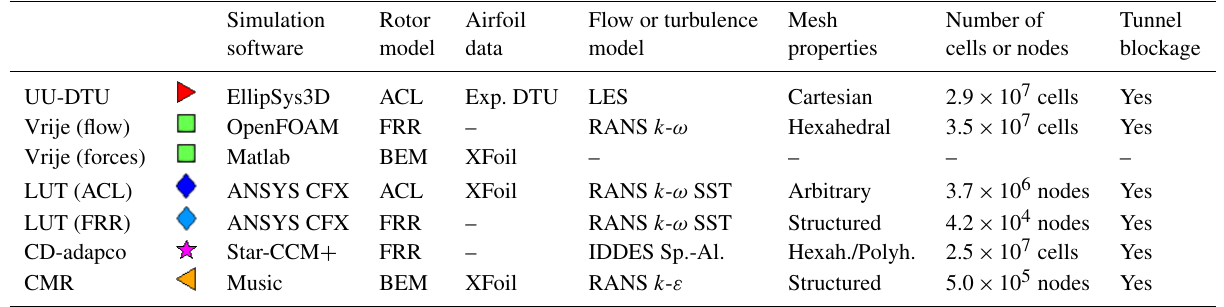
Figure 4. Measured and rotor-averaged values of normalized mean velocity U/U ref (a) and turbulence intensity TI [%] (b) at the position of T1 ( x/D = 0) and the positions of T2 ( x/D = 0, 2.77, 5.18, 9.00) in the empty tunnel for test case C (shear flow grid). Table 1. Overview of simulation methods and parameters. Abbreviations for rotor models: actuator line (ACL), blade element momen- tum (BEM), fully resolved rotor (FRR). Abbreviations for flow models: improved delayed detached eddy simulation (IDDES), large eddy simulation (LES), Reynolds-averaged Navier–Stokes simulation